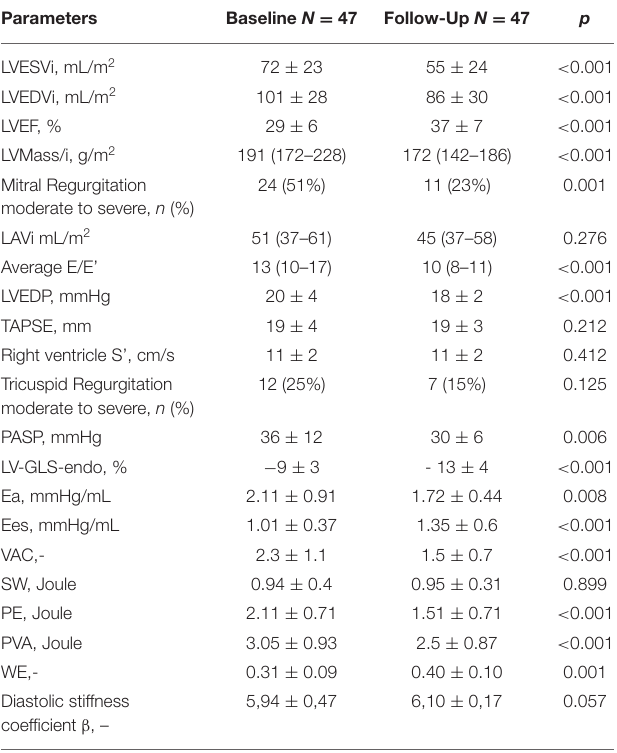
TABLE 3 | Baseline vs. follow-up standard echocardiography parameters, global longitudinal strain and hemodynamic parameters estimated by echocardiography. Parameters